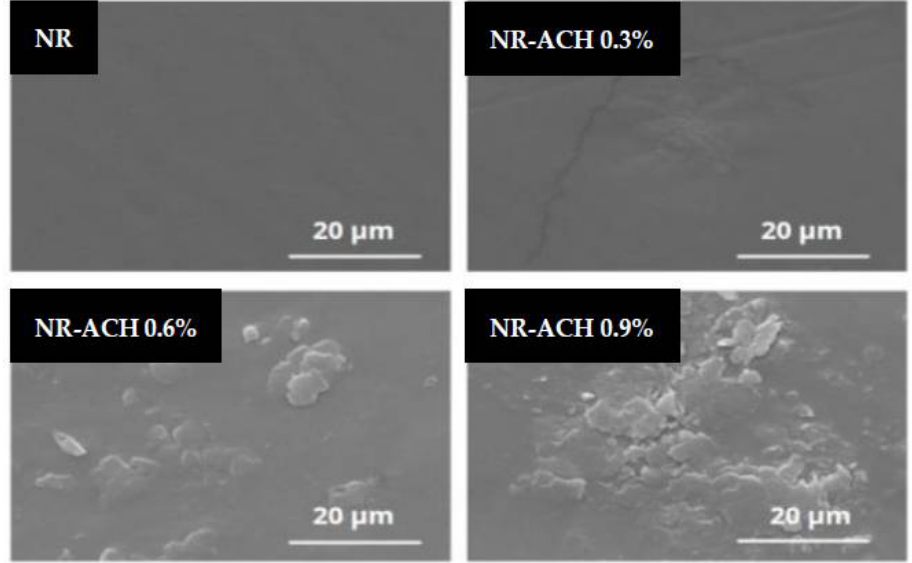
Figure 6. SEM surface images of NR and NR-ACH composite films with ACH concentrations of 0.3%, 0.6%, and 0.9%.